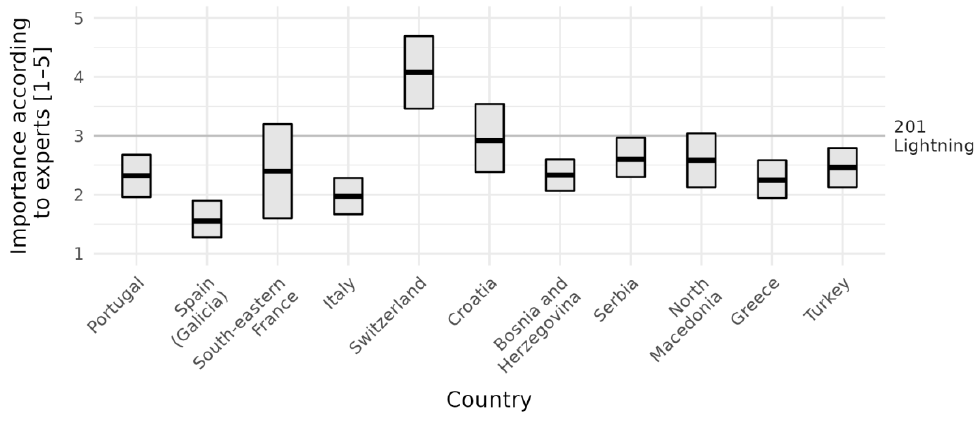
5 Figure 5. Crossbar plot of the importance of ignitions due to Lightning , according to the smean.cl.boot function from the Hmisc R-package, grouped by